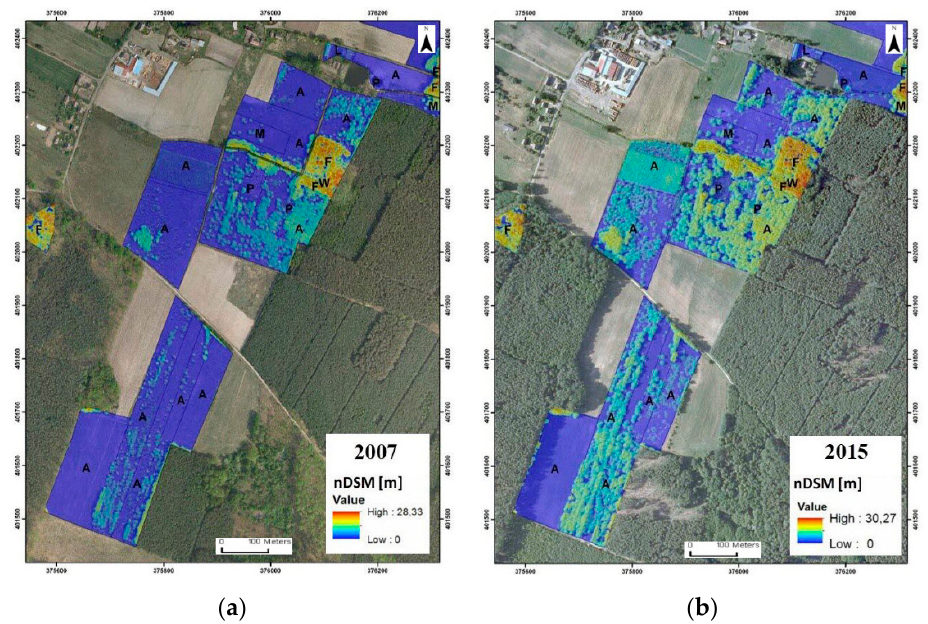
Figure 4. Part of the study area (nDSM) as an example of forest succession area: ( a ) 2007; ( b ) 2015. Background: orthophoto map and cadastral data.